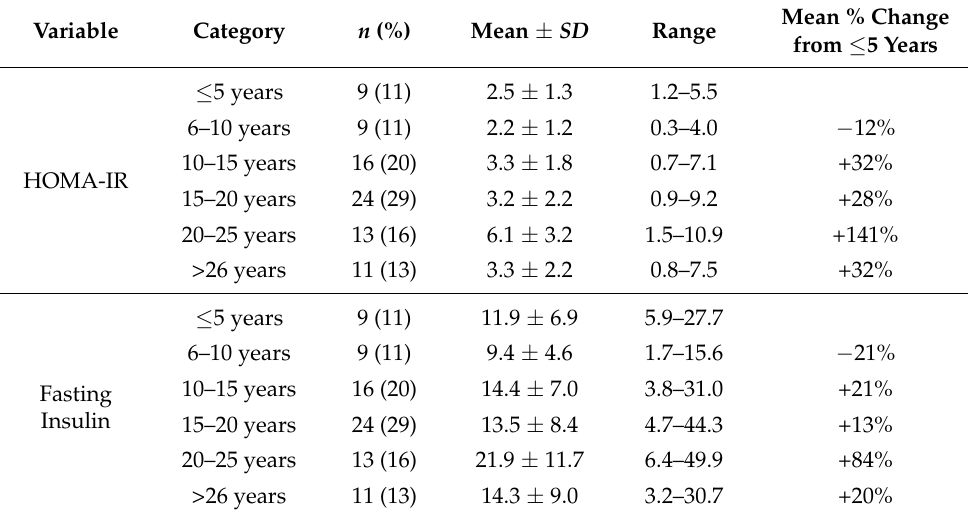
Table 3. Five-Year Trends in HOMA-IR and Fasting Insulin Levels among Study